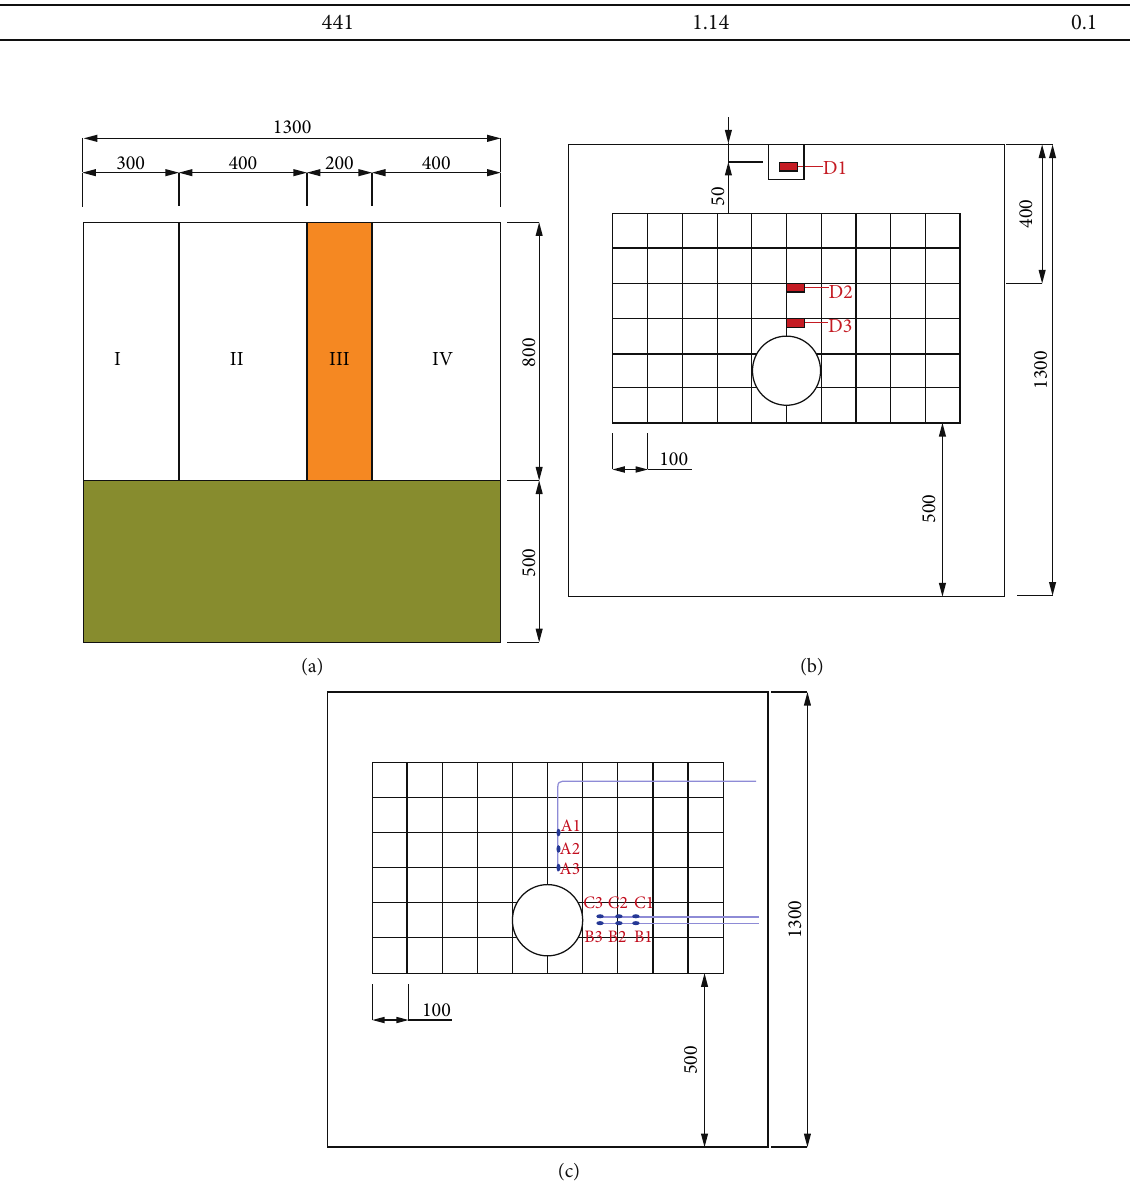
Figure 2: Schematic of the similar model (unit: mm): (a) specimen placement; (b) block position and dynamic pressure sensor placement in part III; (c) grating sensor placement in part